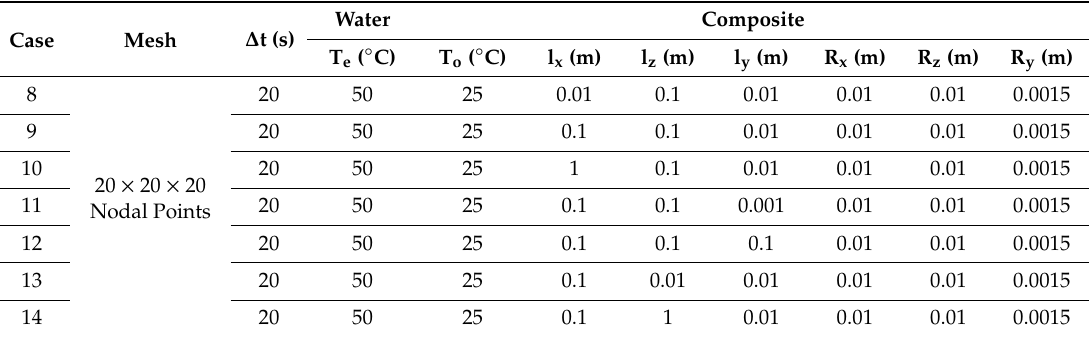
Table 4. Parameters used in the simulation of arbitrary